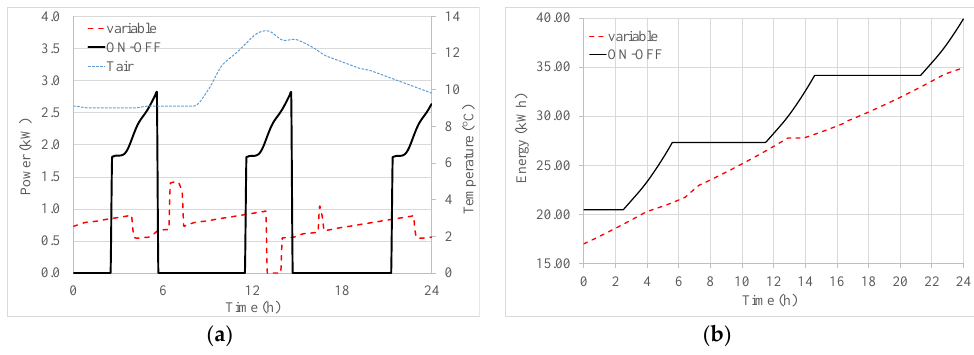
Figure 4. ( a ) Electric power profile and ( b ) cumulative energy curve of the heat pump (HP) in ON-OFF configuration and variable capacity configuration.